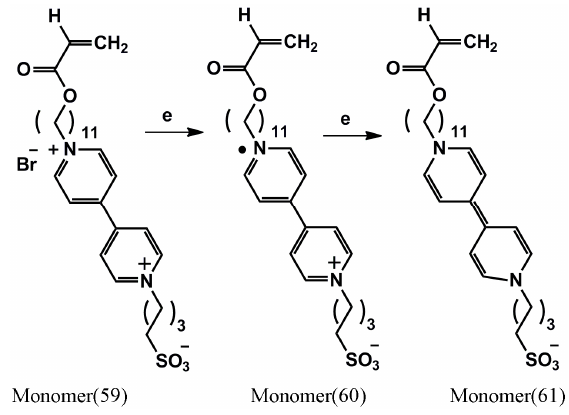
Figure 10. Redox switch on monomer(59) bearing viologen [105].